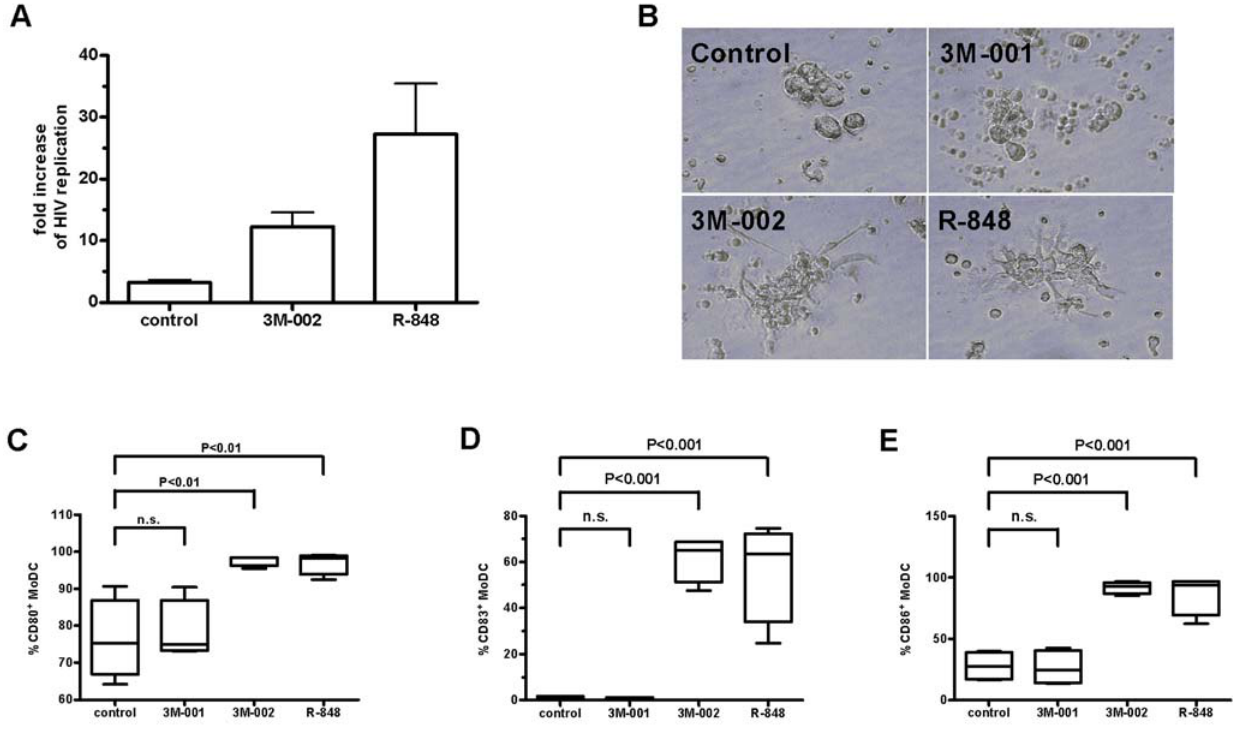
Figure 2. DC are critical in the generation of the microenvironment unfavorable for HIV replication. (A) Depletion of DC and DC precursors resulted in reversal of HIV inhibition (n=2) despite triggering TLR8 and/or 7/8. Represented is the fold increase of HIV replication in PMBC depleted of DC as compared to matched samples. (B) The TLR agonists 3M-002 and R-848 which trigger TLR8 and 7/8 respectively resulted in clumping and activation of MoMDC. This was not the case with 3M-001, which triggers solely TLR7. (C–E) Triggering TLR8 or 7/8 resulted in marked activation of MoMDC as quantified by the cell-surface expression of CD80, CD83, and CD86 (n=4). Data were first analyzed by one-way analysis of variance and if tested significantly different, by Bonferroni’s multiple comparison test.